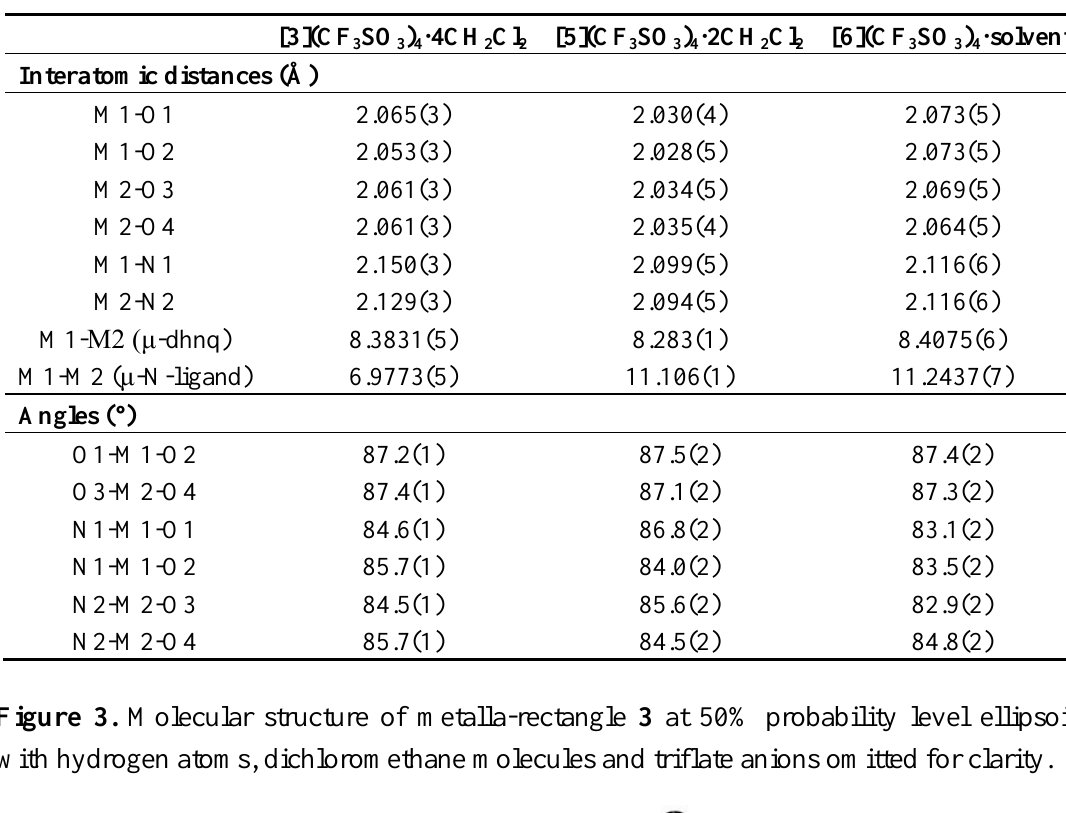
SO ) ·solvent. 3 3 4